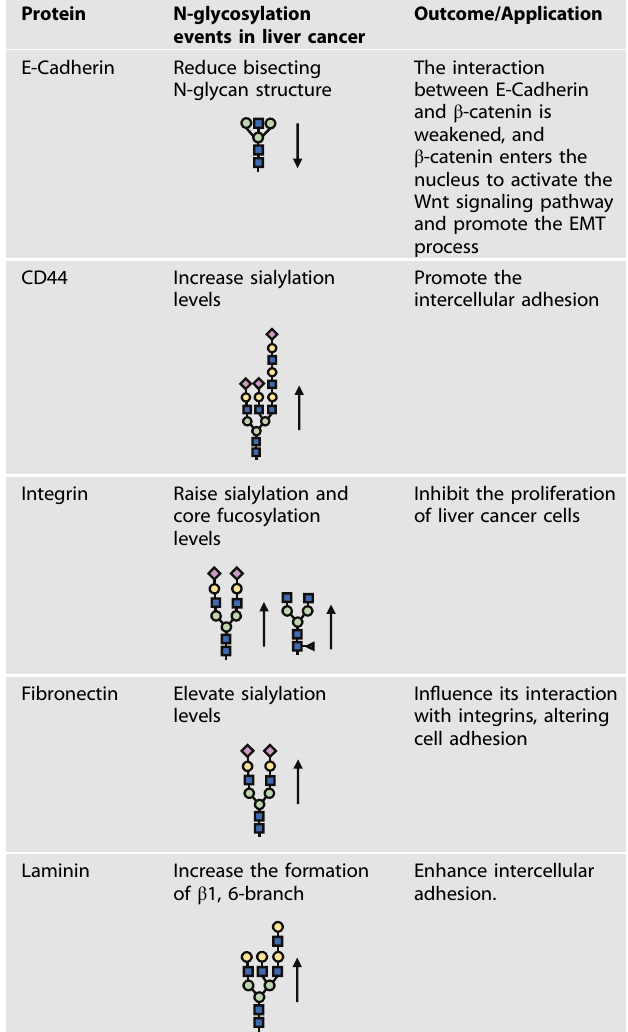
Table 2. Important N-glycosylation events in liver